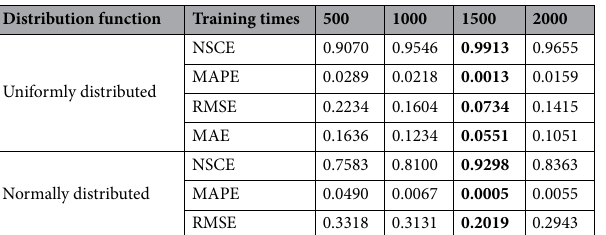
Table 4. The NSCE, MAPE, RMSE and MAE of T–S FNN with different training times. Significant values are in [bold].